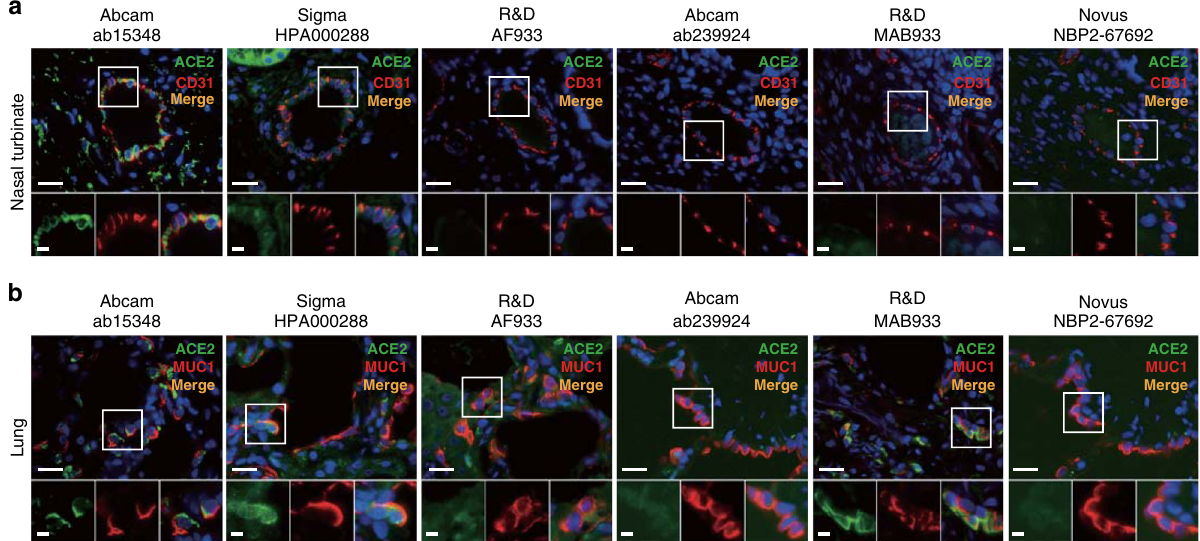
Fig. 2 ACE2 protein expression within human vascular endothelial cells and the lung. a Representative double immuno fl uorescence staining of ACE2 and endothelial cell marker CD31 in the blood vessels of human nasal turbinates using six different anti-ACE2 antibodies and anti-CD31. b Double immuno fl uorescence staining of ACE2 and type II pneumocyte marker mucin 1 (MUC1) in the human lung using six different anti-ACE2 antibodies and anti-MUC1. Abcam ab15348 clone yielded the most robust staining of pneumocytes, while the other clones showed negligible or less speci fi c membrane staining. Scale bars: 20 μ m (top) and 5 μ m